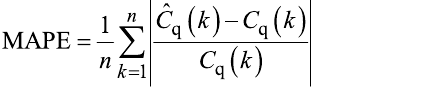
algorithm converges to the optimized values with an